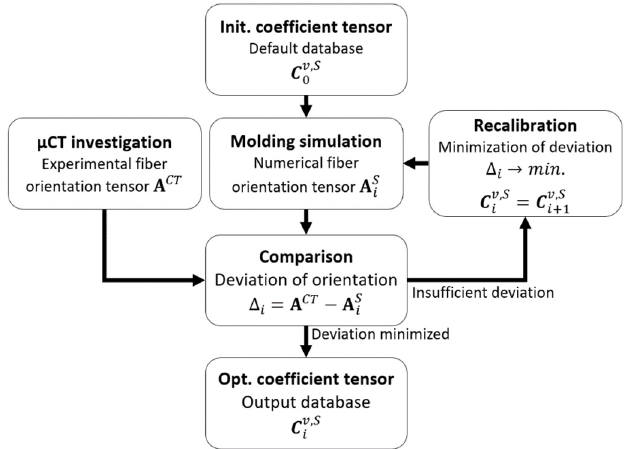
Figure 1. Method for calibrating the calculated fiber orientation of injection molding simulations in comparison to experimental µCT investigations.